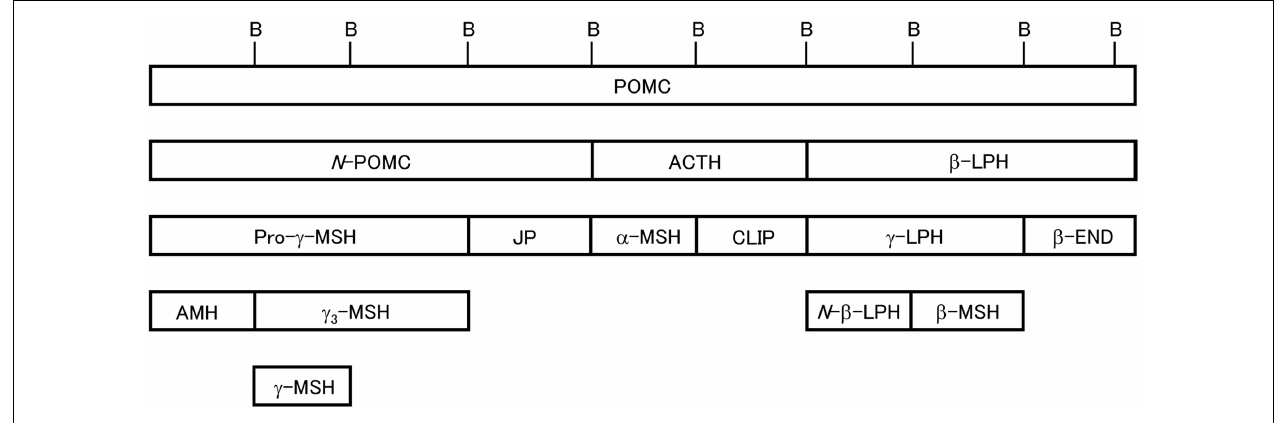
peptide segments. In teleost POMC, N -POMC is not divided into subsegments due to the absence of a γ -MSH segment and pairs of basic amino